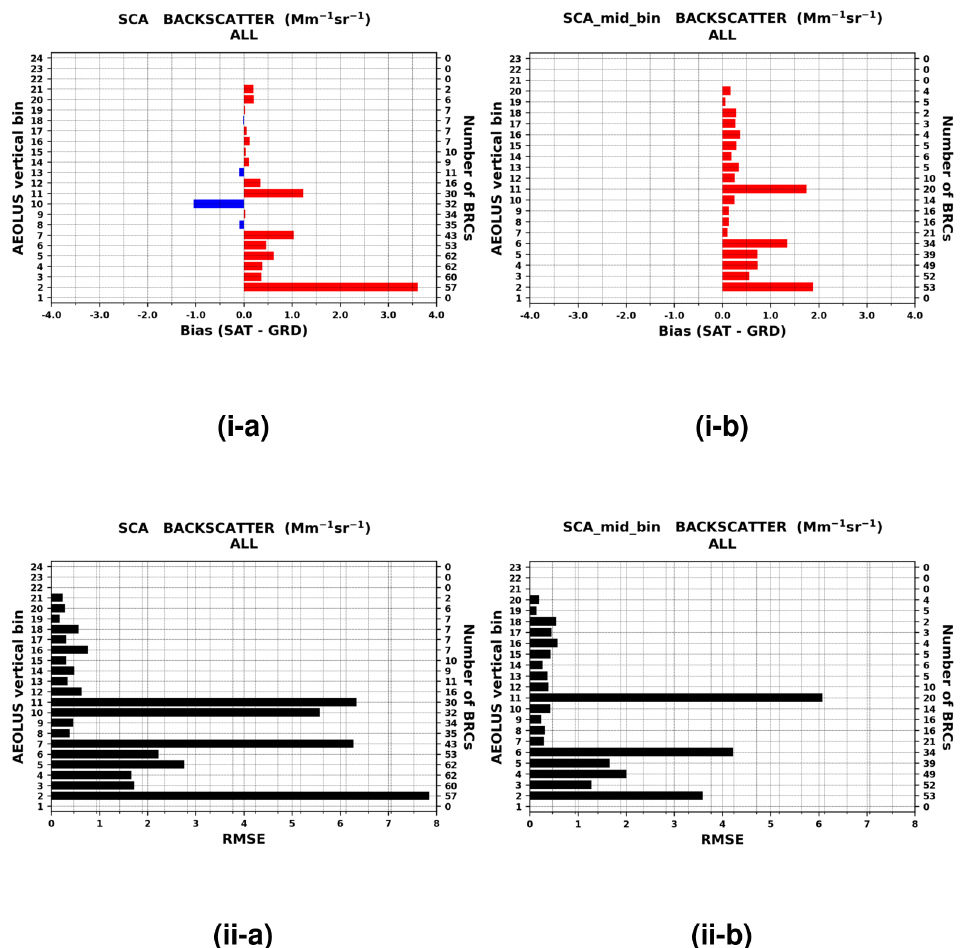
Figure 4. Bias (i) and root mean square error (ii) metrics for the unfiltered Aeolus L2A backscatter retrievals reported at the regular (a) and mid-bin (b) vertical scales. The biases are defined as SAT-GRD, and the positive/negative departures are depicted with red or blue bars. The statistical metrics are vertically resolved based on Aeolus bin indices (left y axis). The number of BRCs participating in the metrics calculations at each bin are given on the right y